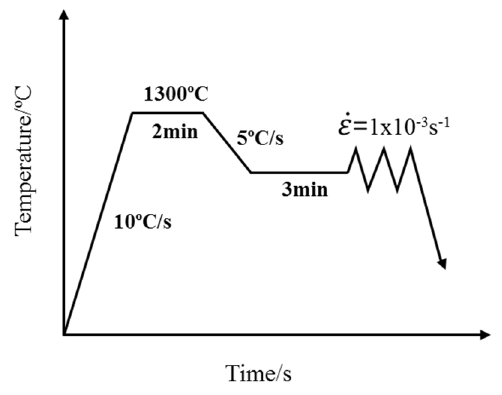
Figure 5. Temperature setting for the tensile test.